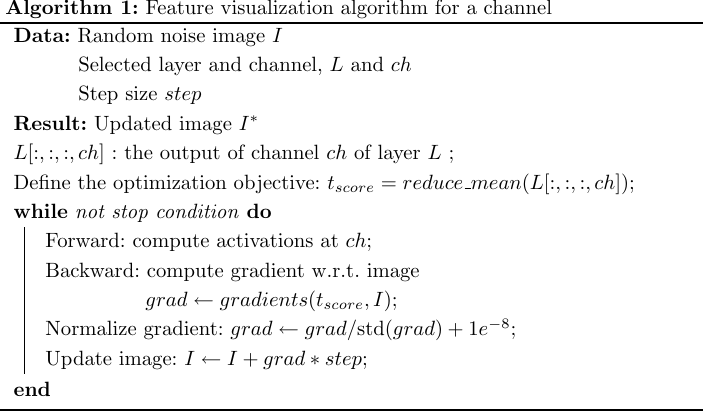
Algorithm 1: Feature visualization algorithm for a